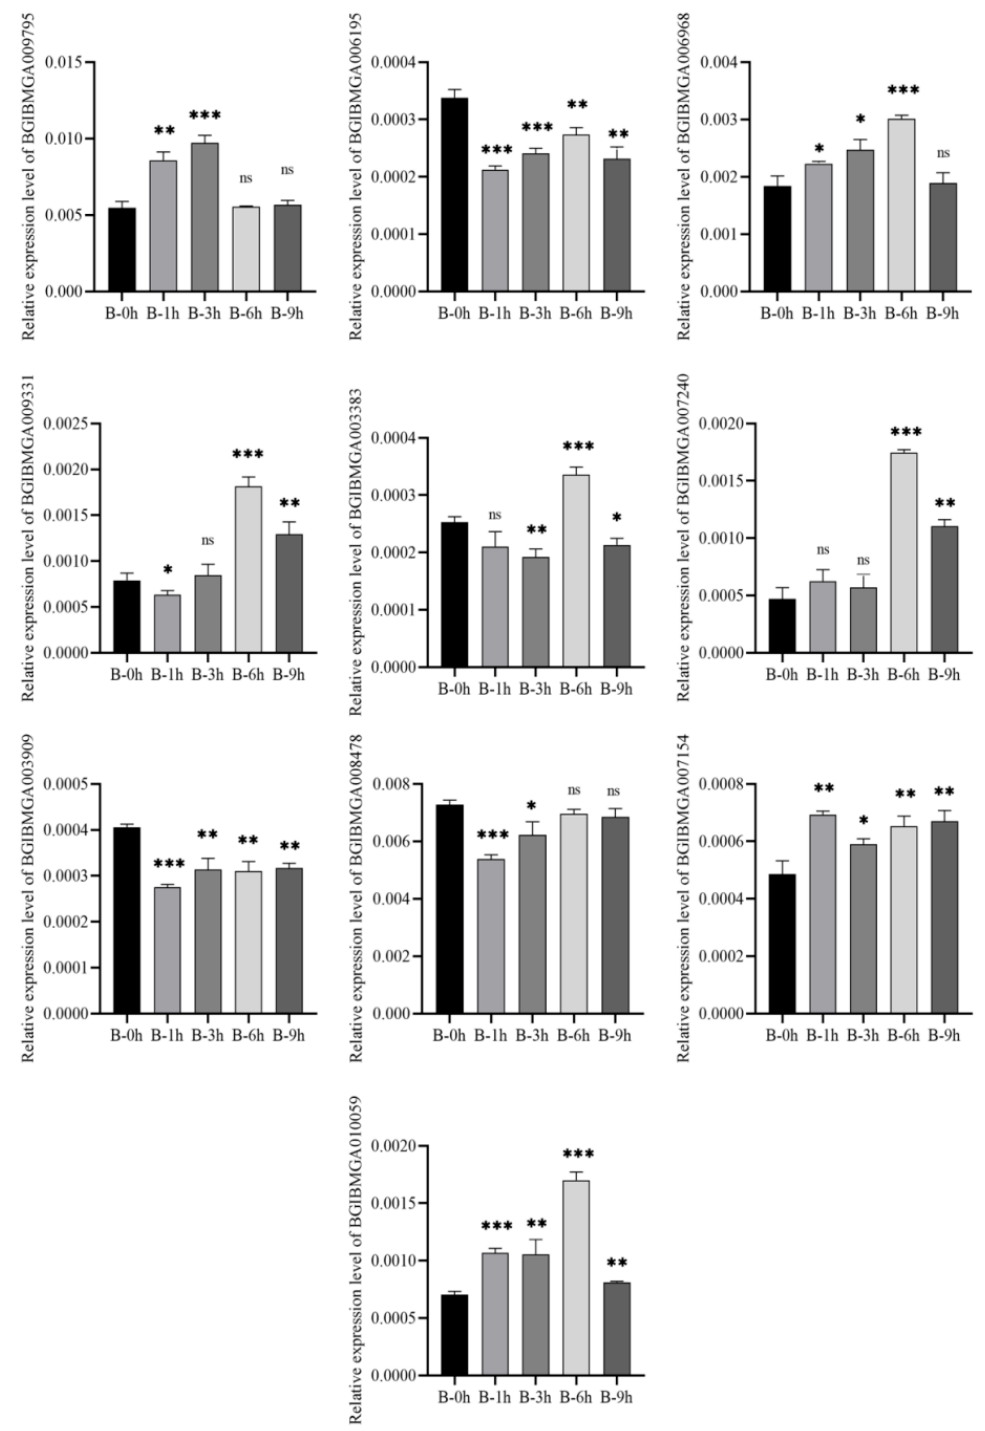
Figure 7. Quantification of 10 DEGs at 1, 3, 6, and 9 h after BmNPV infection in the B variety by qRT-PCR. Significant differences are indicated by asterisks ( p < 0.05). ns, not significant. *, p < 0.05; **, p < 0.01; ***, p < 0.001.